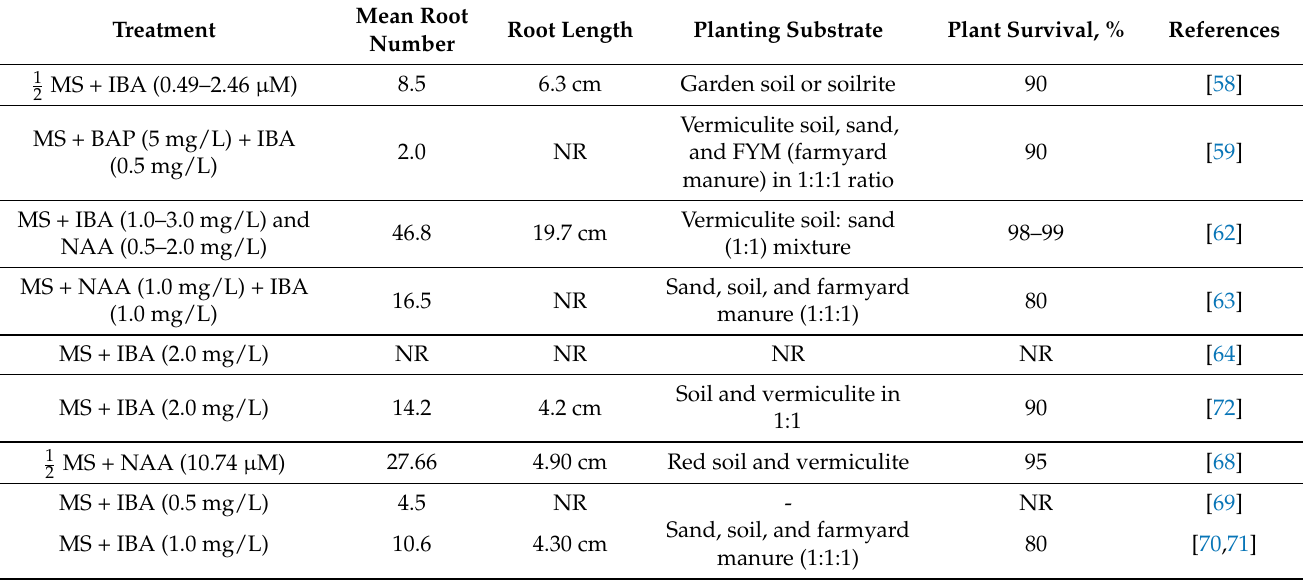
Table 6. In vitro rooting in C. asciatica